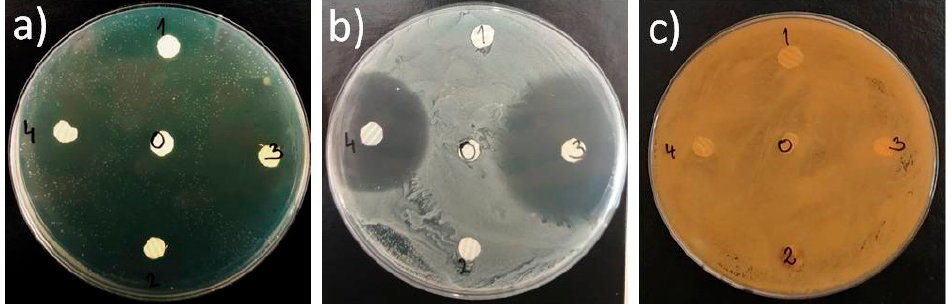
Figure 11. Antimicrobial activity of the electrospun scaffolds against: ( a ) Pseudomonas aeruginosa 3024, ( b ) Staphylococcus aureus 3048 and ( c ) Candida albicans 11.